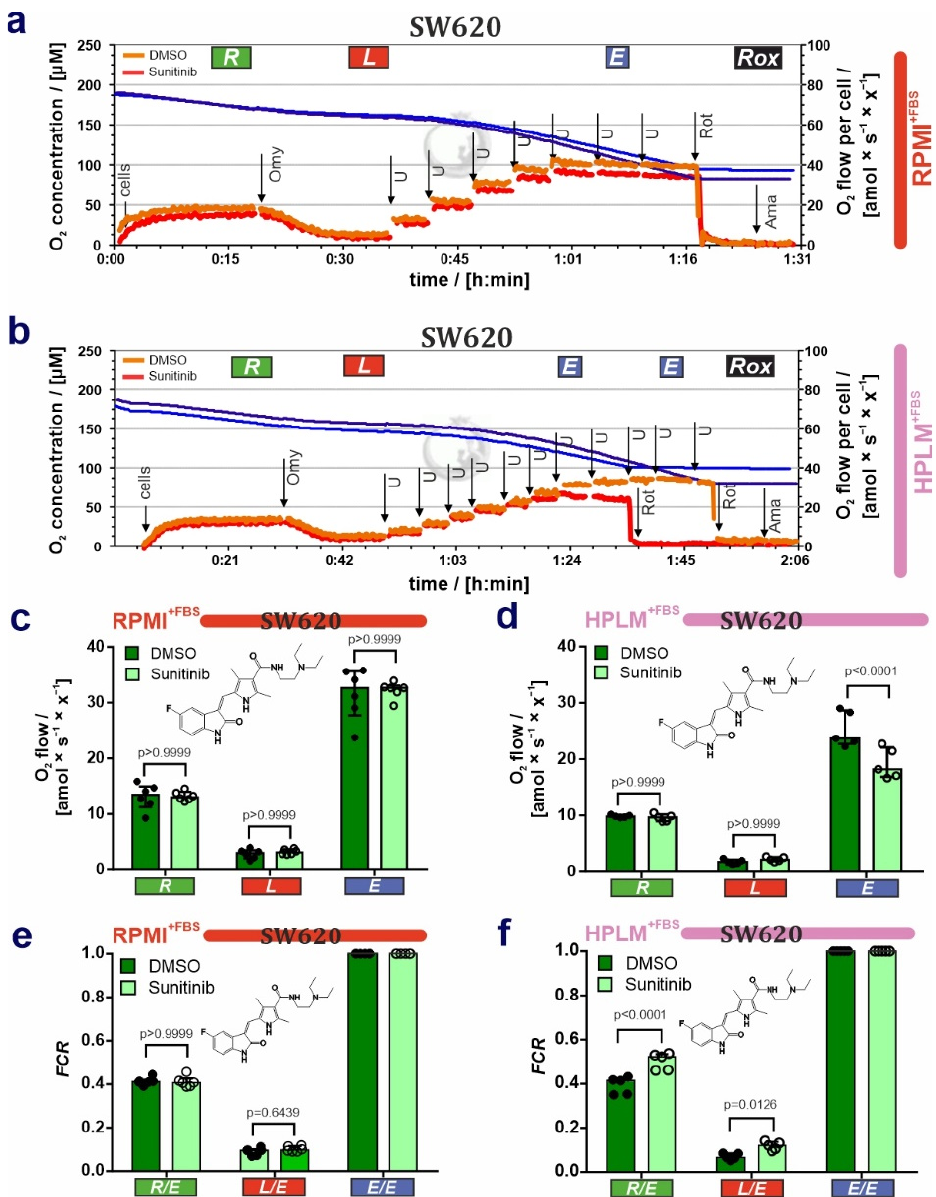
Figure 5. Differential effects of sunitinib on cell respiration of SW620 cells grown in RPMI or HPLM. ( a , b ) Representative respiratory traces for coupling control protocol SUIT-003-D009 in SW620 cells grown in ( a ) RPMI +FBS and ( b ) HPLM +FBS , and exposed to 10 µ M sunitinib for 3 h. Blue lines: O 2 concentration [ µ M]; light orange lines: O 2 flow per cell amol × s − 1 × x − 1 ] in DMSO control; and dark orange lines: O 2 flow per cell [amol × s − 1 × x − 1 ] in sunitinib-treated cells. “x” represents the unit cell. ( c , d ) O 2 flow ( R , L , E ) [amol × s − 1 × x − 1 ] baseline-corrected for Rox in ( c ) RPMI +FBS and ( d ) HPLM +FBS . ( e , f ) Flux control ratios FCR in SW620 cells grown in ( e ) RPMI +FBS and ( f ) HPLM +FBS and exposed to sunitinib (chemical structure depicted). Median ± IQR (50% range). 2-way ANOVA with Bonferroni ´ s multiple comparison test; N =